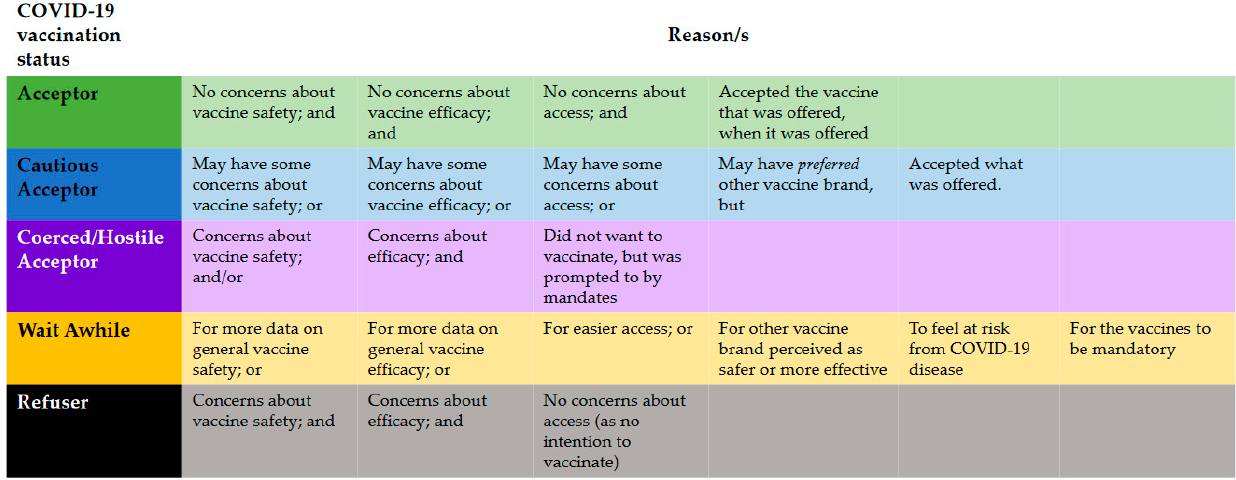
Figure 1. The recommended course of vaccines.